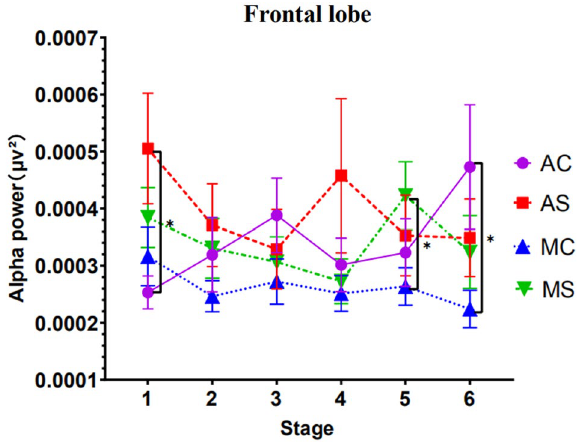
Figure 8. EEG frontal area alpha wave power (Note: Vertical bars represent standard errors, * p < 0.05).